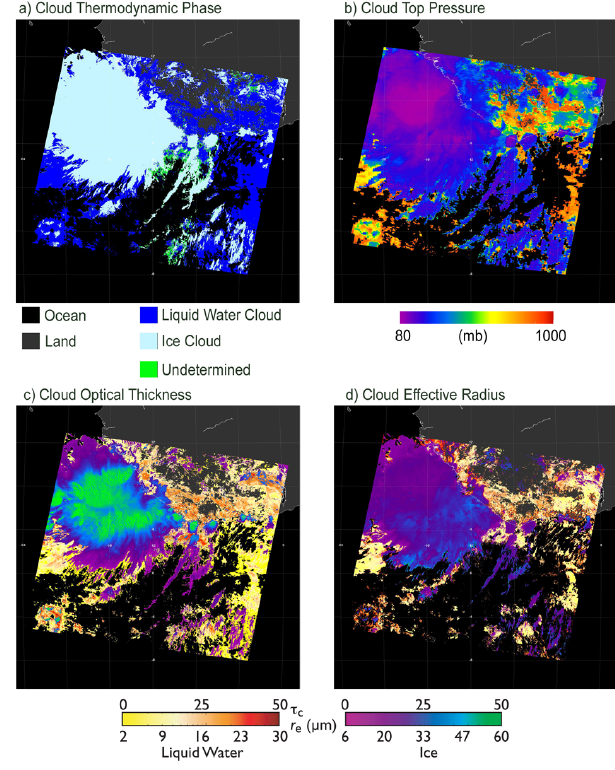
Fig. 6. Example cloud retrieval for simulated granule covered by Terra MODIS 2013 day 151 11:15UTC. (a) is cloud thermody- namic phase, (b) cloud top pressure, (c) cloud optical thickness and (d) cloud effective radius from the 0.86–2.1µm band combination.